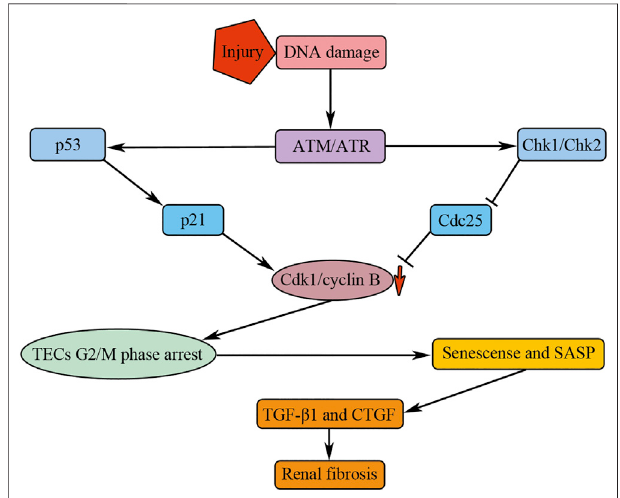
FIGURE 4 | G2/M phase arrest of TECs mediates renal fi brosis by secreting pro fi brotic cytokines. Injuries result in the activation of ATM/ATR, which could promote the activation of Chk1/Chk2 and p53. p53 and Chk1/ Chk2 could induce downregulation of Cdk1/cyclin B kinase activity by affecting p21 and Cdc25, respectively. The downregulation of Cdk1/cyclin B kinase activity results in TECs G2/M phase arrest; the arrested cells undergo senescence and manifest senescence-associated secretory phenotype (SASP),causingrenal fi brosisbysecreting pro fi broticcytokines,suchasTGF- β 1 and